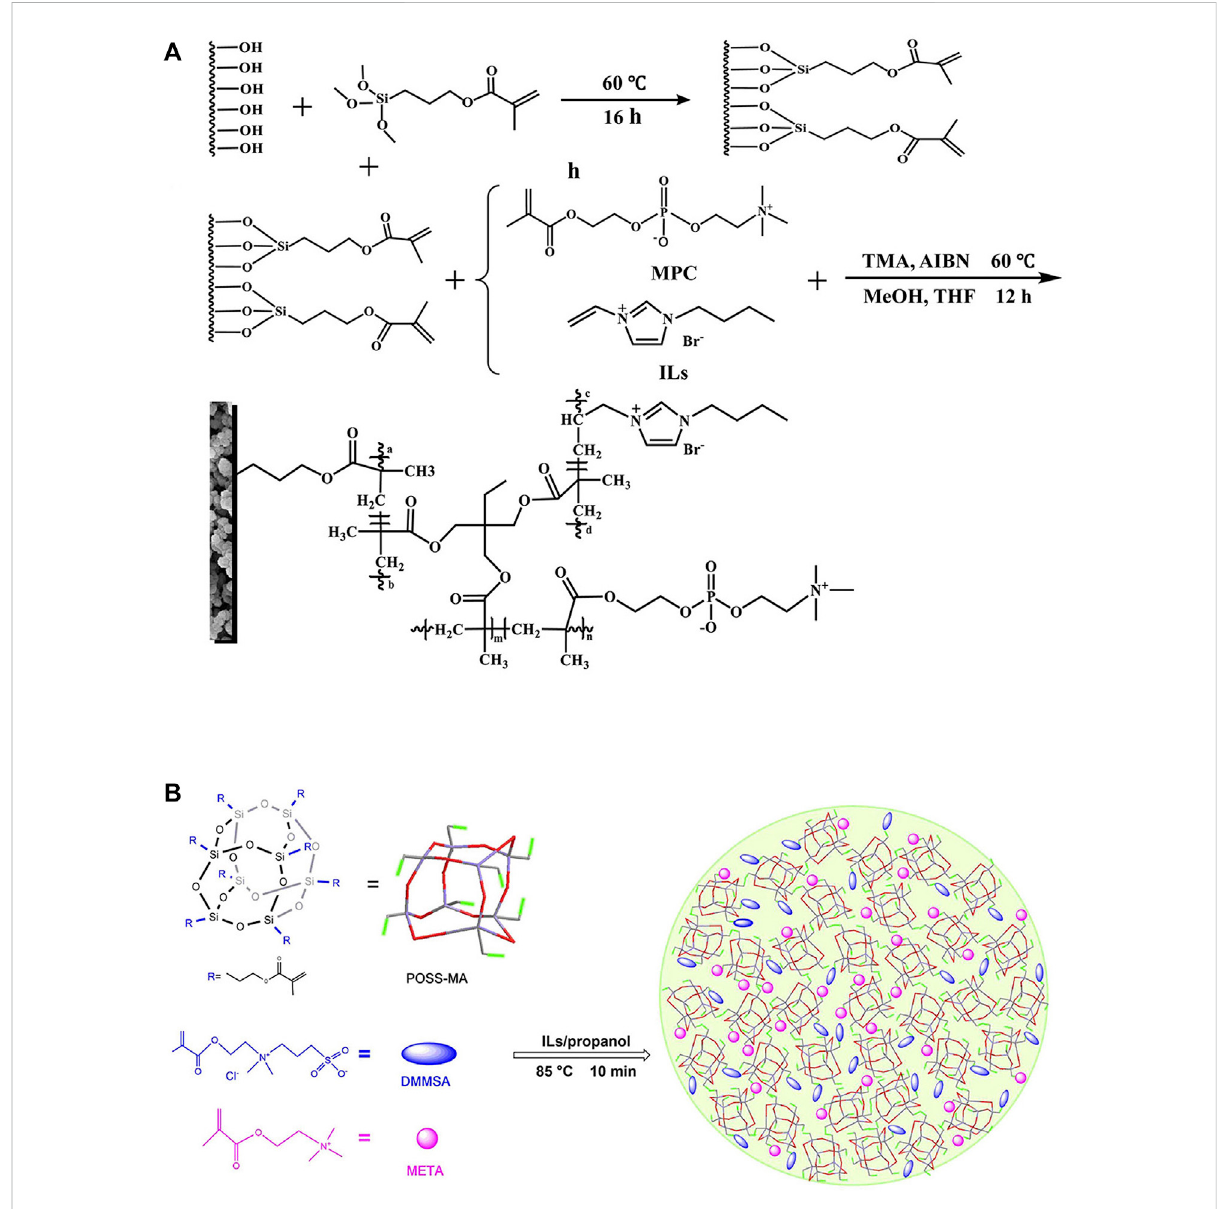
FIGURE 3 (A) : Preparation of poly (MPC-co-ILs-co-TMA) monolithic column. Reprinted with permission from Ref [34]. Copyright 2020 Elsevier. (B) : Preparation of poly (POSS-co-META-co-DMMSA) monolithic column. Reprinted with permission from Ref. [37]. Copyright 2021 Elsevier.